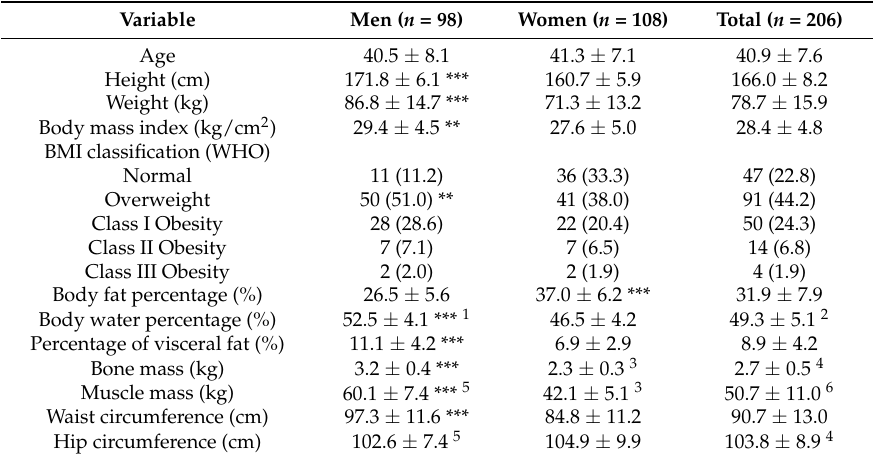
Table 3. Anthropometric characteristics of the